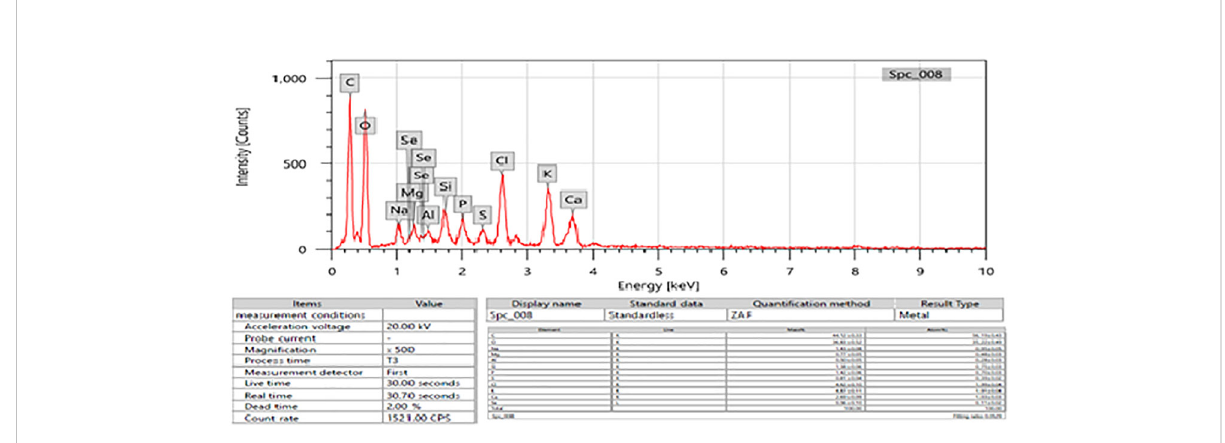
FIGURE 7 EDX analysis of